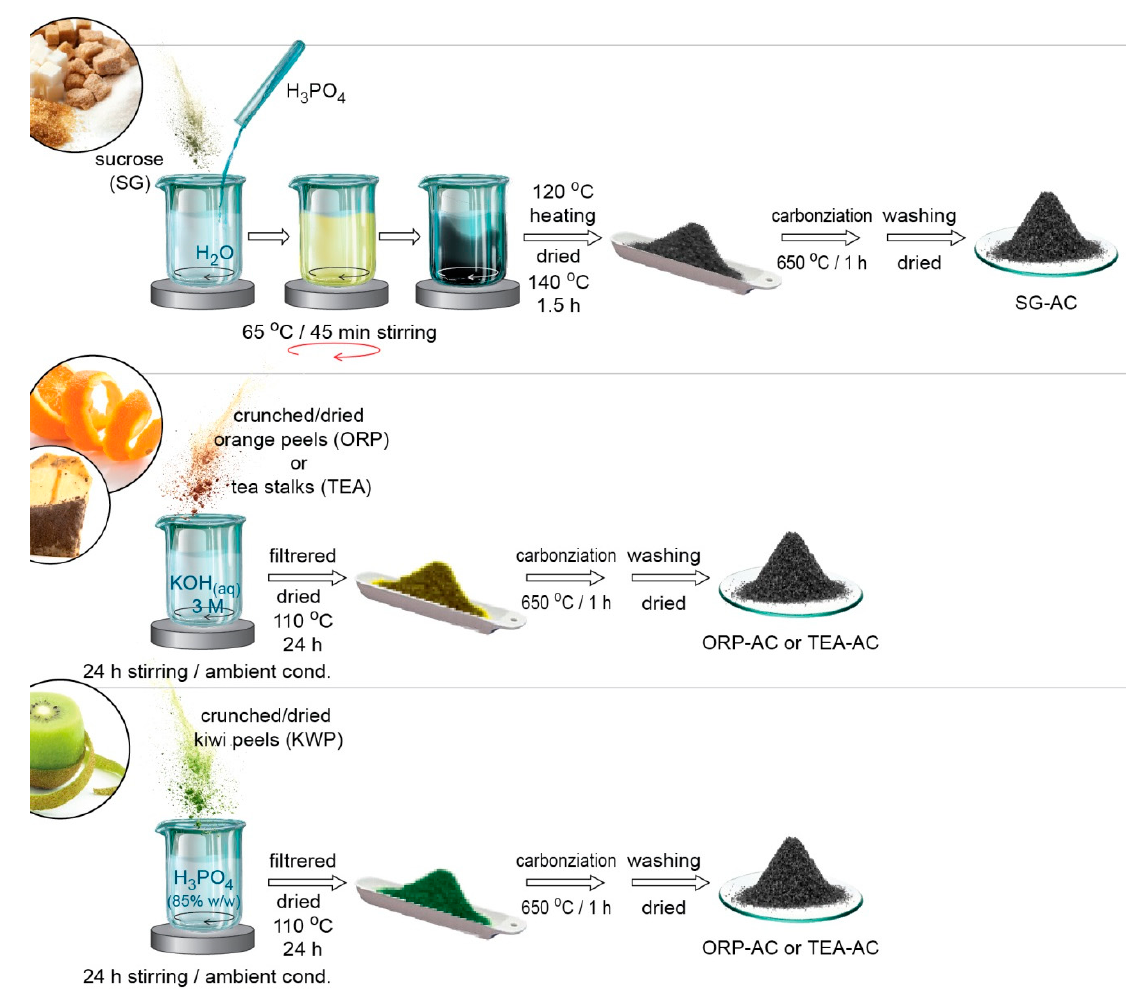
Figure 2. Synthesis procedure of activated carbon (AC) samples.